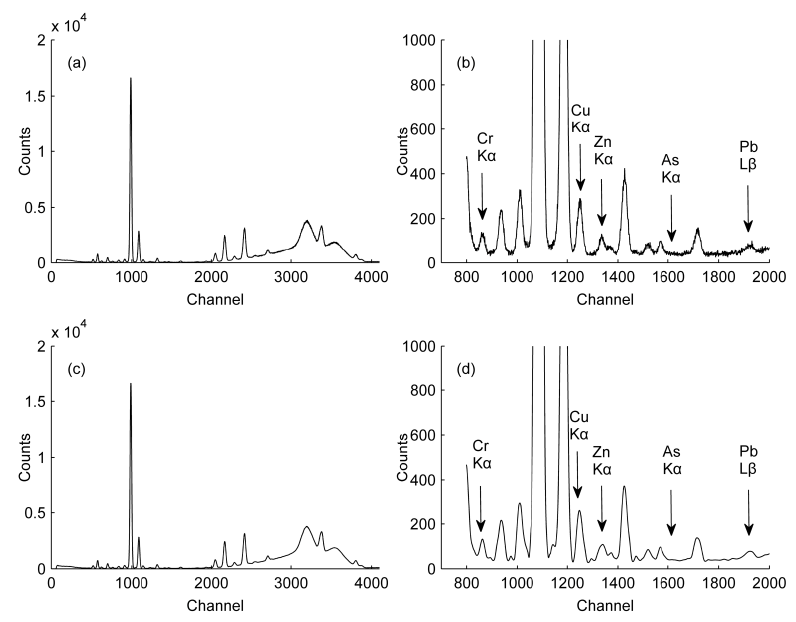
Figure 3. Denoising results with coif 3 at level 3: ( a ) Original signal; ( b ) Enlarged view of ( a ); ( c ) Denoised signal; ( d ) Enlarged view of ( c ).